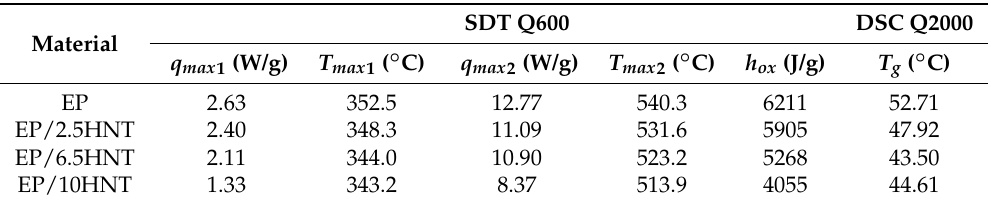
Table 1. Summary of the main parameters derived from the DSC thermograms obtained by various